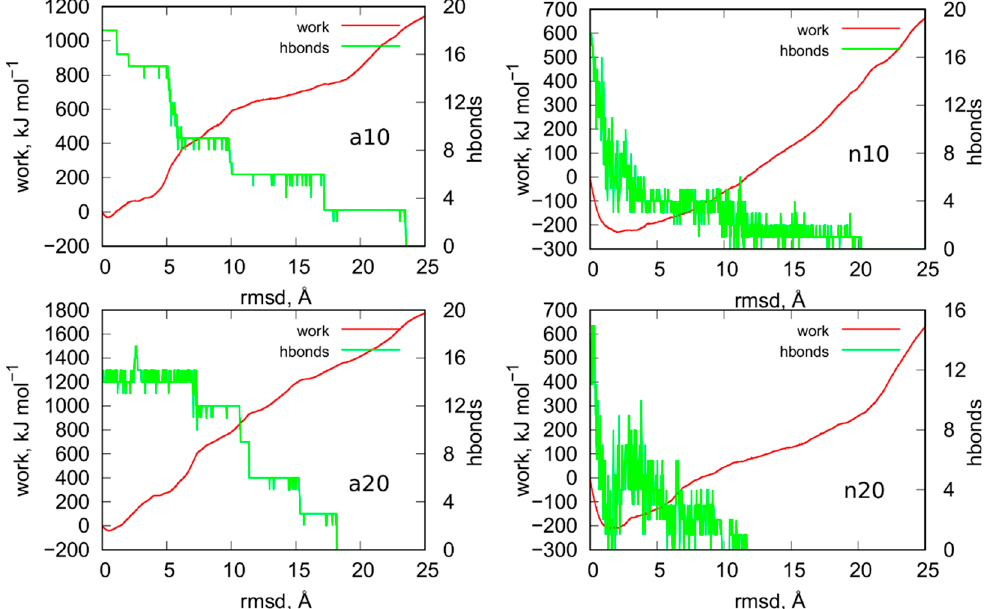
Figure 9. Works measured during the enforced unfoldings of iM parts of iG in biased steered molecular dynamics simulations. The biasing forces were imposed on atoms involved in formation of hydrogen bonds between C:C+ pairs and the moving restraints were imposed on the rmsd of given structures from the initial states. Green curves show how the number of hydrogen bond changes with the rmsd.